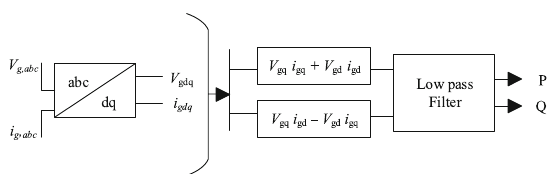
Fig. 3 Power controller